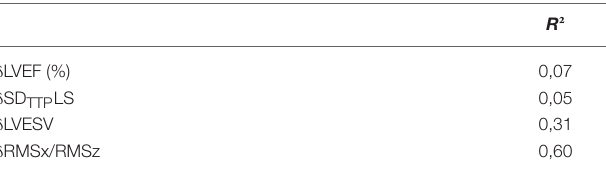
TABLE 3 | Correlations between early changes (“ δ ”, from PRE to POST implant) of main echocardiographic parameters and difference of LVESV from PRE to follow-up ( 1